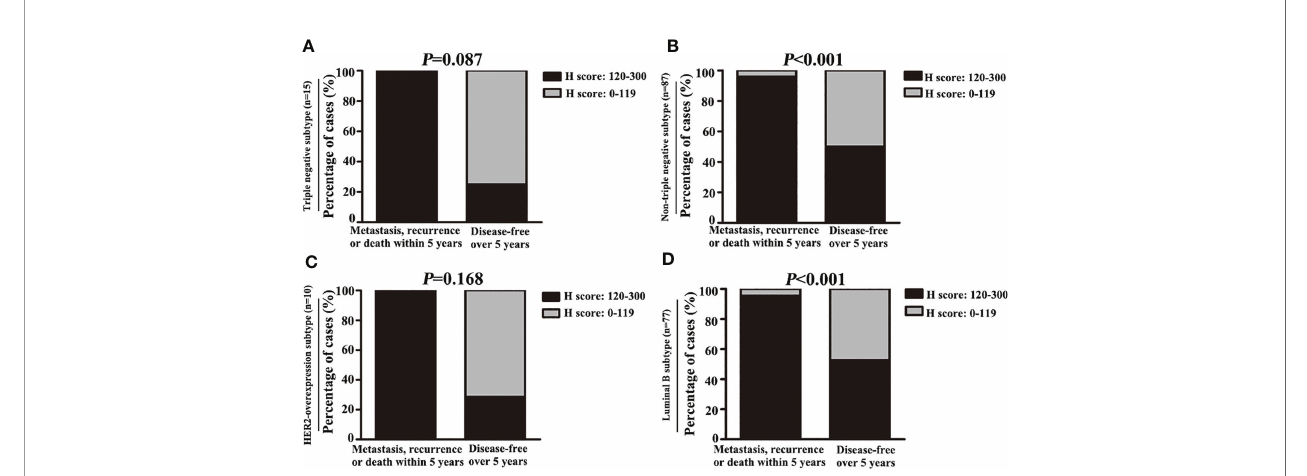
FIGURE 8 | High expression of C7 promoted disease progression in luminal B subtype patients treated with TE-based chemotherapy. (A, B) Among patients treated with TE-based chemotherapy, the percentage of high C7 expression in patients who developed metastasis, recurrence, or death within 5 years was higher than those who were disease-free over 5 years in the non-triple negative subtype (B) , but not in the triple negative subtype (A) . (C, D) Among patients treated with TE-based chemotherapy, the percentage of high C7 expression in patients who developed metastasis, recurrence, or death within 5 years was higher than those who were disease-free over 5 years in the luminal B subtype (D) , but not in the HER2 overexpression subtype (C) . [ (A – D) : c 2